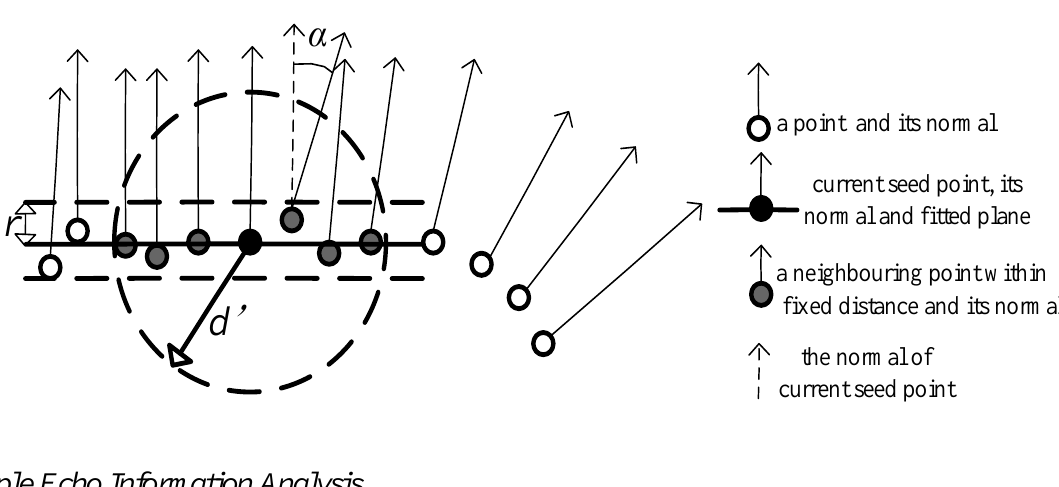
Figure 3. Parameters of the point cloud smooth segmentation (PCSS) segmentation. For a seed point with normal vector and a fitted plane across the seed point, select its neighboring points whose 3D distance to the seed point within d' . Among the neighboring points, add the points, whose angle difference to seed points is less than α and whose distance to the fitted plane is less than r , to the